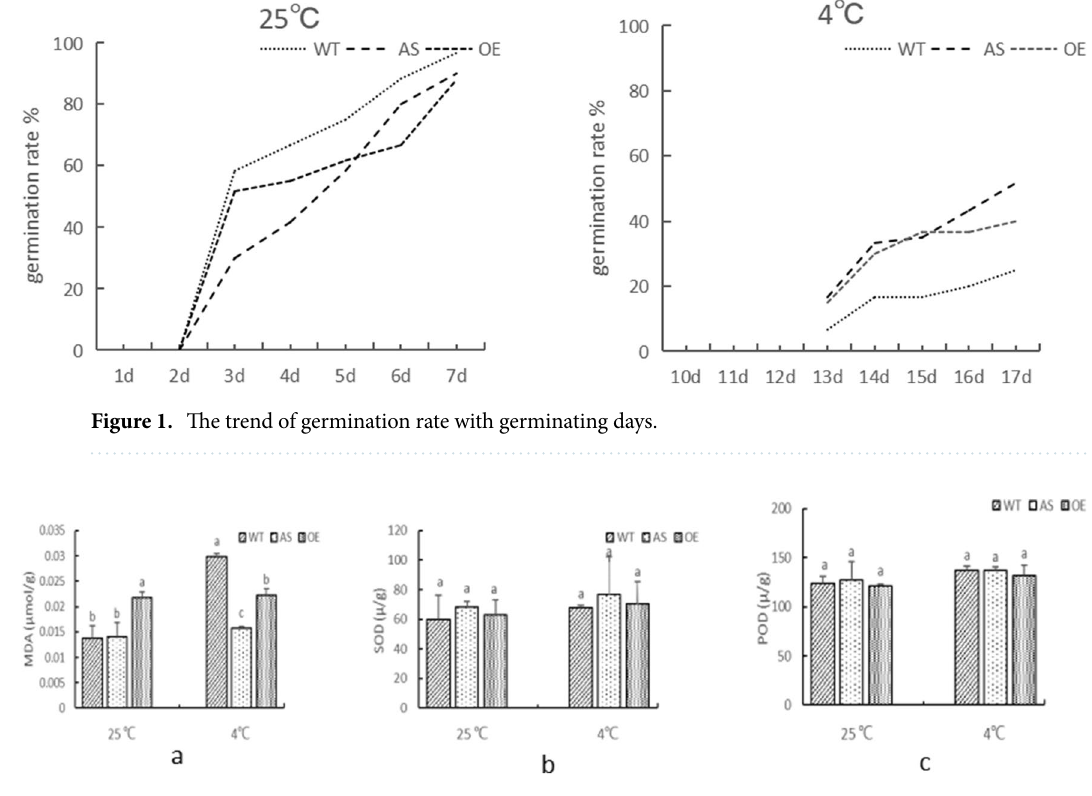
Figure 2. Effects of low temperature on physiological indexes of maize seedling leaves. ( a ) Effects of low temperature on MDA content in maize seedling leaves; ( b ) effects of low temperature on SOD enzyme activity in maize seedling leaves; ( c ) effects of low temperature on POD activity in maize seedling leaves. Different lowercase letters indicate significant differences in physiological indicators between plants ( P < 0.05).